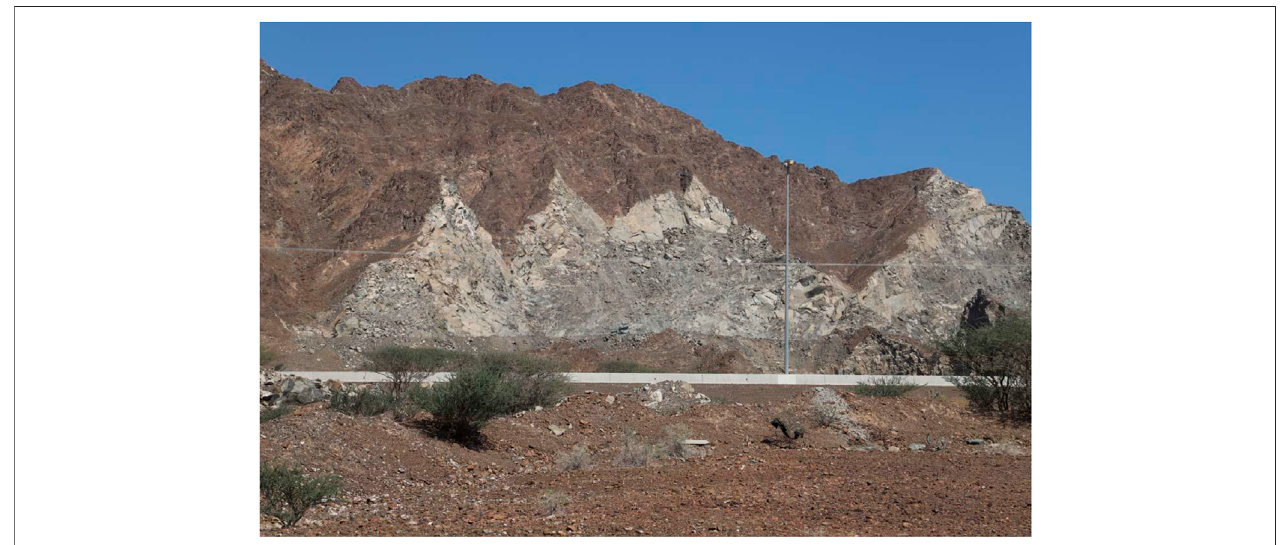
FIGURE 5 | It is very similar to one above. It shows the freshly exposed unweathered serpentinized peridotite in more detail. It also shows intense fracture zones, some of which are joints, others are spaced faults and narrow ductile shears. Some of the close spaced fracture sets are related to the quarrying process.